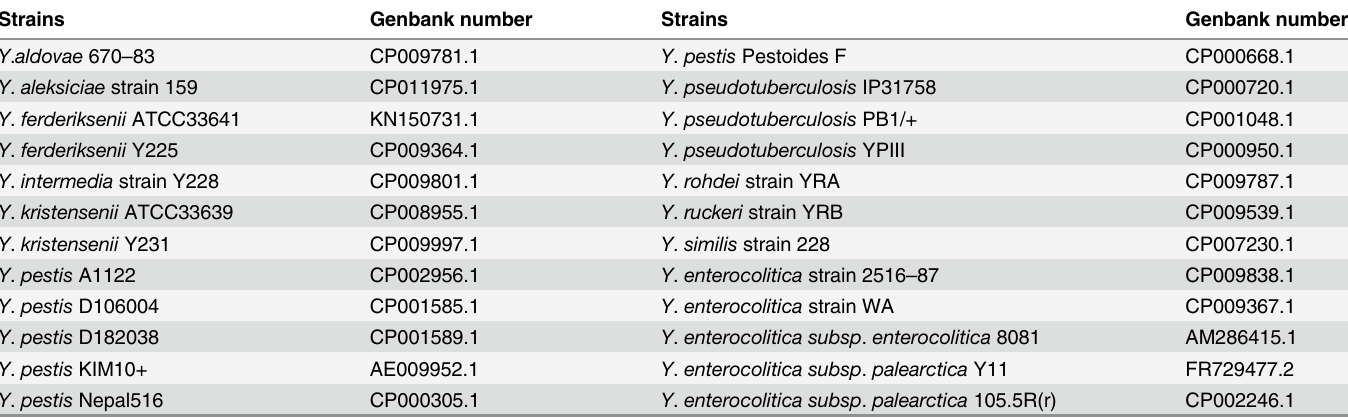
Table 2. The GenBank numbers of 24 complete-genome-sequenced strains.